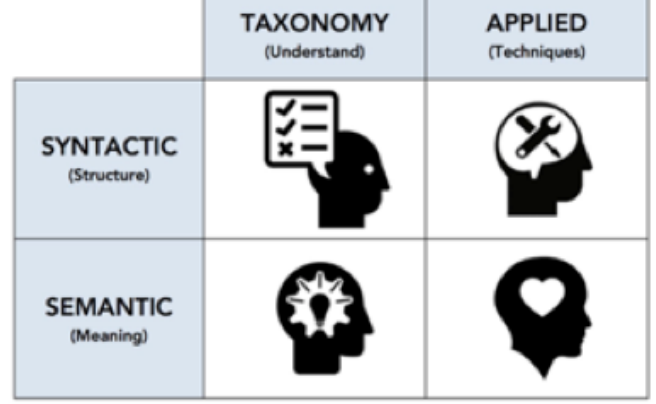
Figure 1: The Film Sound Analysis Framework Conceptual Model